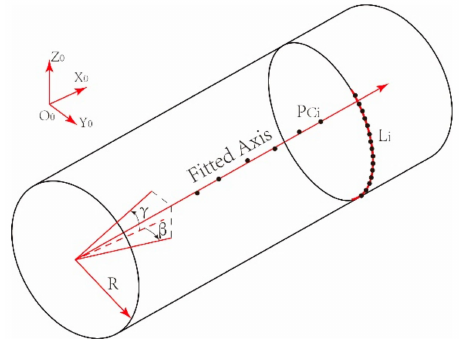
Figure 3. Diagram of posture estimation for the